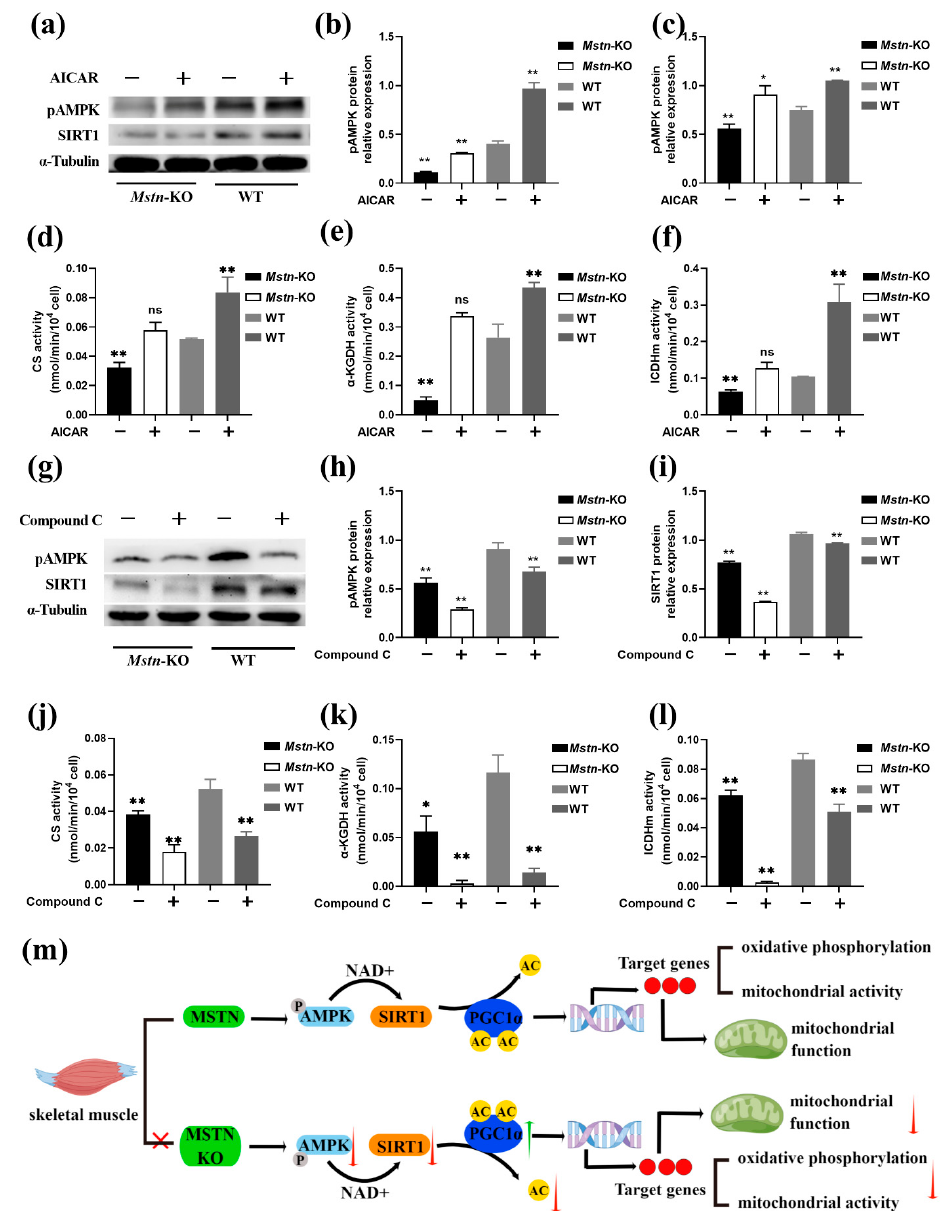
Figure 7. Expression of pAMPK and SIRT1 following treatment with AICAR and Compound C. ( a ) The expression of SIRT1 and pAMPK with AICAR treatment Mstn -KO and WT cells. ( b , c ) Quantitative analysis showing the expression of pAMPK and SIRT1 following treatment with AICAR ( n = 3). ( d ) Citrate synthase (CS) activity with AICAR treatment Mstn -KO and WT cells ( n = 3). ( e ) α -ketoglutarate acid dehydrogenase ( α -KGDH) activity with AICAR treatment Mstn -KO and WT cells ( n = 3). ( f ) Isocitrate dehydrogenase (ICDHm) activity with AICAR treatment Mstn -KO and WT cells ( n = 3). ( g ) The expression of SIRT1 and pAMPK with Compound C treatment Mstn -KO and WT cells. ( h , i ) Quantitative analysis showing the expression of pAMPK and SIRT1 following treatment with Compound C ( n = 3). ( j ) Citrate synthase (CS) activity with Compound C treatment Mstn -KO and WT cells ( n = 3). ( k ) α -ketoglutarate acid dehydrogenase ( α -KGDH) activity with Compound C treatment Mstn -KO and WT cells ( n = 3). ( l ) Isocitrate dehydrogenase (ICDHm) activity with Compound C treatment Mstn -KO and WT cells ( n = 3). ( m ) Pattern of MSTN knockdown affecting mitochondrial function through the AMPK/SIRT1/PGC1 α pathway. All data are presented as mean ± SD. ns, non-significant p > 0.05; * p < 0.05; ** p < 0.01; t-tests were used to calculate the p